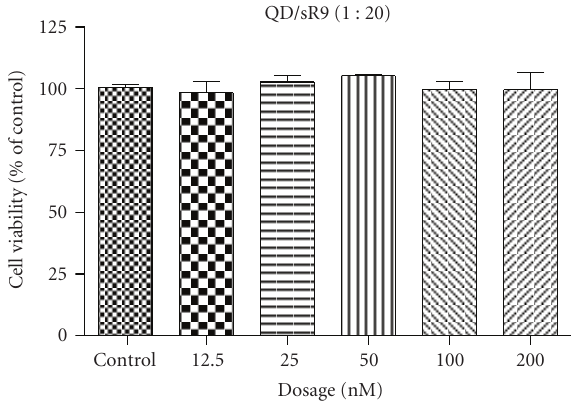
Figure 4: Cell viability of QD/SR9-treated cells. A549 cells were treated with QD/SR9 (1:20) for 24 hours. The concentrations of QDs used were 12.5, 25, 50, 100, and 200 nM. Values are mean ± SD from three independent